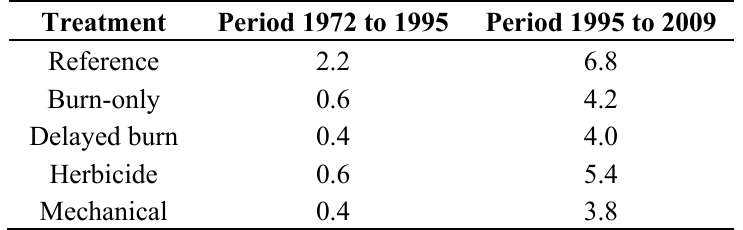
Table 1. Average number of burns ( i.e. , number of burns divided by number of plots for each period) for the period between 1972 and 1994, and 1995 and 2009 for each